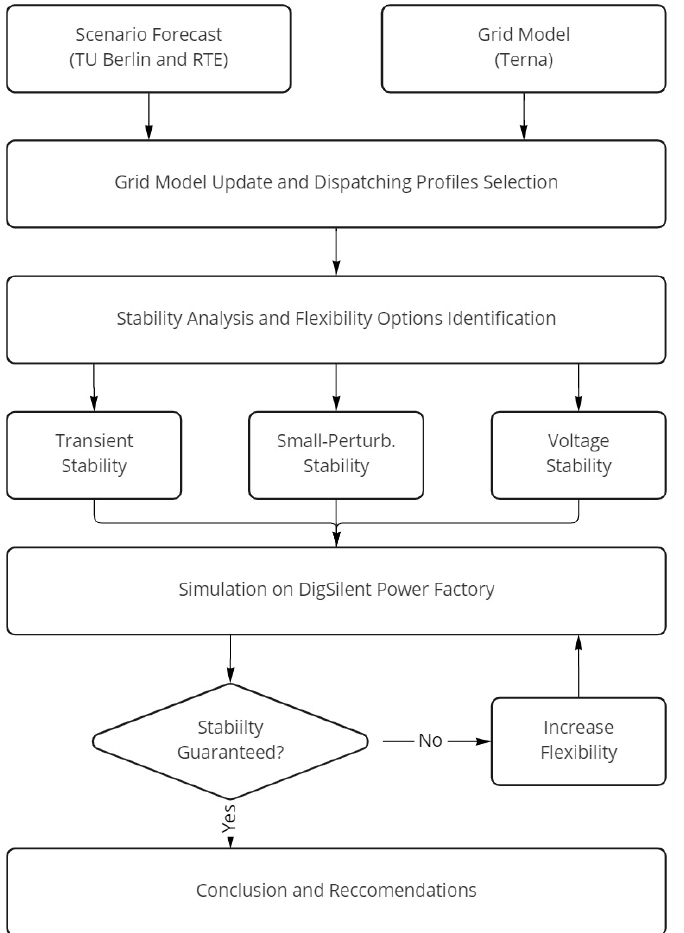
Figure 7. Stability analysis: methodology flowchart.